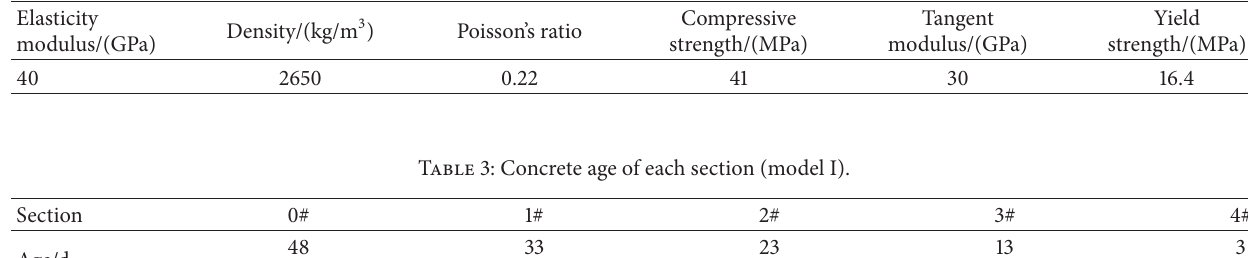
Table 2: Physical and mechanical parameters of bedrock.